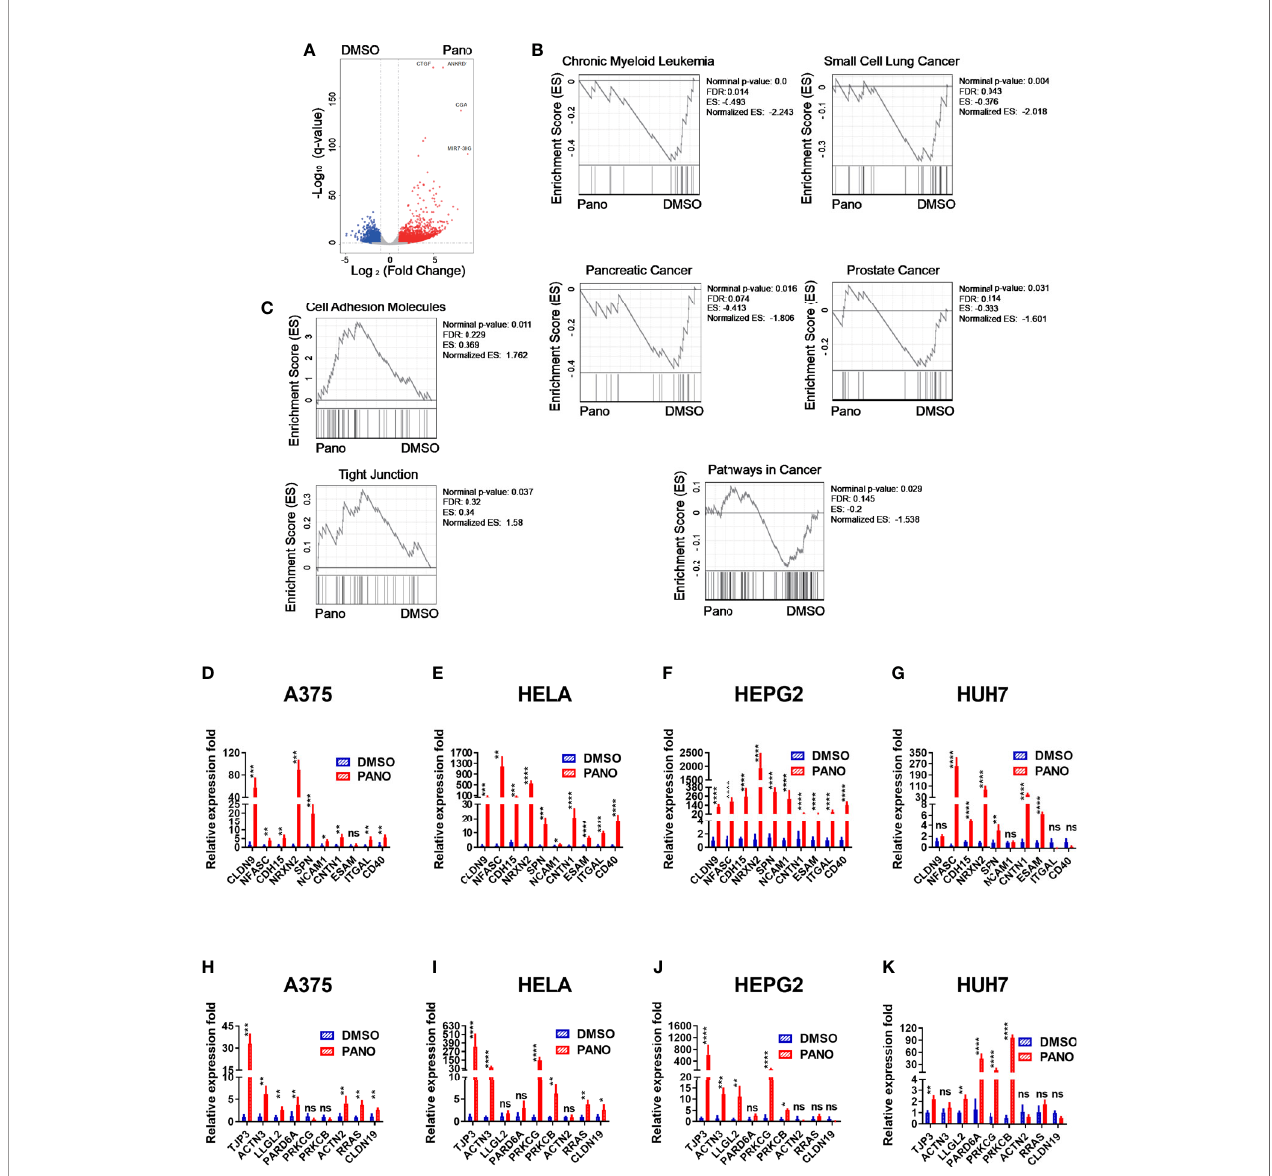
FIGURE 3 | Transcriptome analysis of A375 cells treated with HDACi (Panobinostat) and RT-qPCR validation of cell-adhesion and tight junction gene expression from RNA-seq. A375 cells were treated with 50nM Panobinostat and DMSO control for 24 hours prior to RNA isolation and transcriptome analysis (n = 3). (A) Differentially expressed genes were shown. (B, C) Gene sets enriched in either the DMSO or Panobinostat groups. (D – K) The expression levels for the top ten differentially expressed genes from the cell-adhesion and tight junction related genes were assessed using the RT-qPCR relative to the expression of Beta Actin. (D – G) cell-adhesion gene sets, (H – K) tight junction gene sets. (D, H) human skin cell carcinoma A375, (E, I) human cervical carcinoma HeLa, (F, J) human hepatocellular carcinoma HepG2, (G, K) human hepatocarcinoma Huh7. Relative expression fold is expressed as mean ± SD (n =4 replicates) from three independent experiments. Statistical signi fi cance was assessed by t-test (D – K) (not signi fi cant ns, P >0.05, *P ≤ 0.05, **P ≤ 0.01, ***P ≤ 0.001, ****P ≤